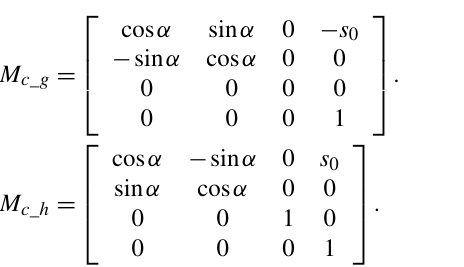
Figure 2. The coordinate conversion between S c and S m . tooth surface to rack normal surface.